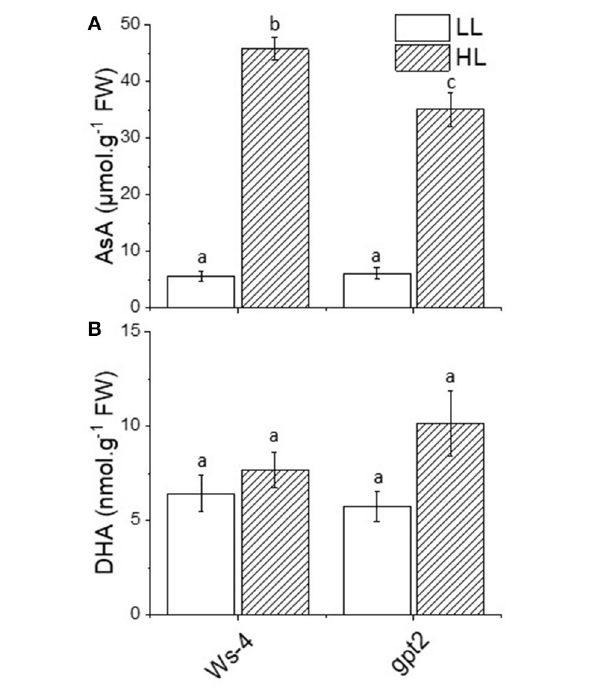
FIGURE 4 | Antioxidant content of the Ws-4 wild type and gpt2 plants. The leaf content of ascorbic acid (AsA0) (A) and dehydroascorbate (DHA) (B) in plants that were grown for 7 weeks at 100 µ mol m − 2 s − 1 light and then either maintained at 100 µ mol m − 2 s − 1 for 7 more days (LL) or transferred to conditions with an irradiance of 400 µ mol m − 2 s − 1 (HL). Leaves were flash-frozen under growth conditions. Extractions and measurements were done on the same day to minimise the rapid oxidation of AsA to DHA in the sample. The data were analysed using a two-way ANOVA followed by Tukey’s test at p ≤ 0.05 to be significantly different. Different lowercase letters denote significantly